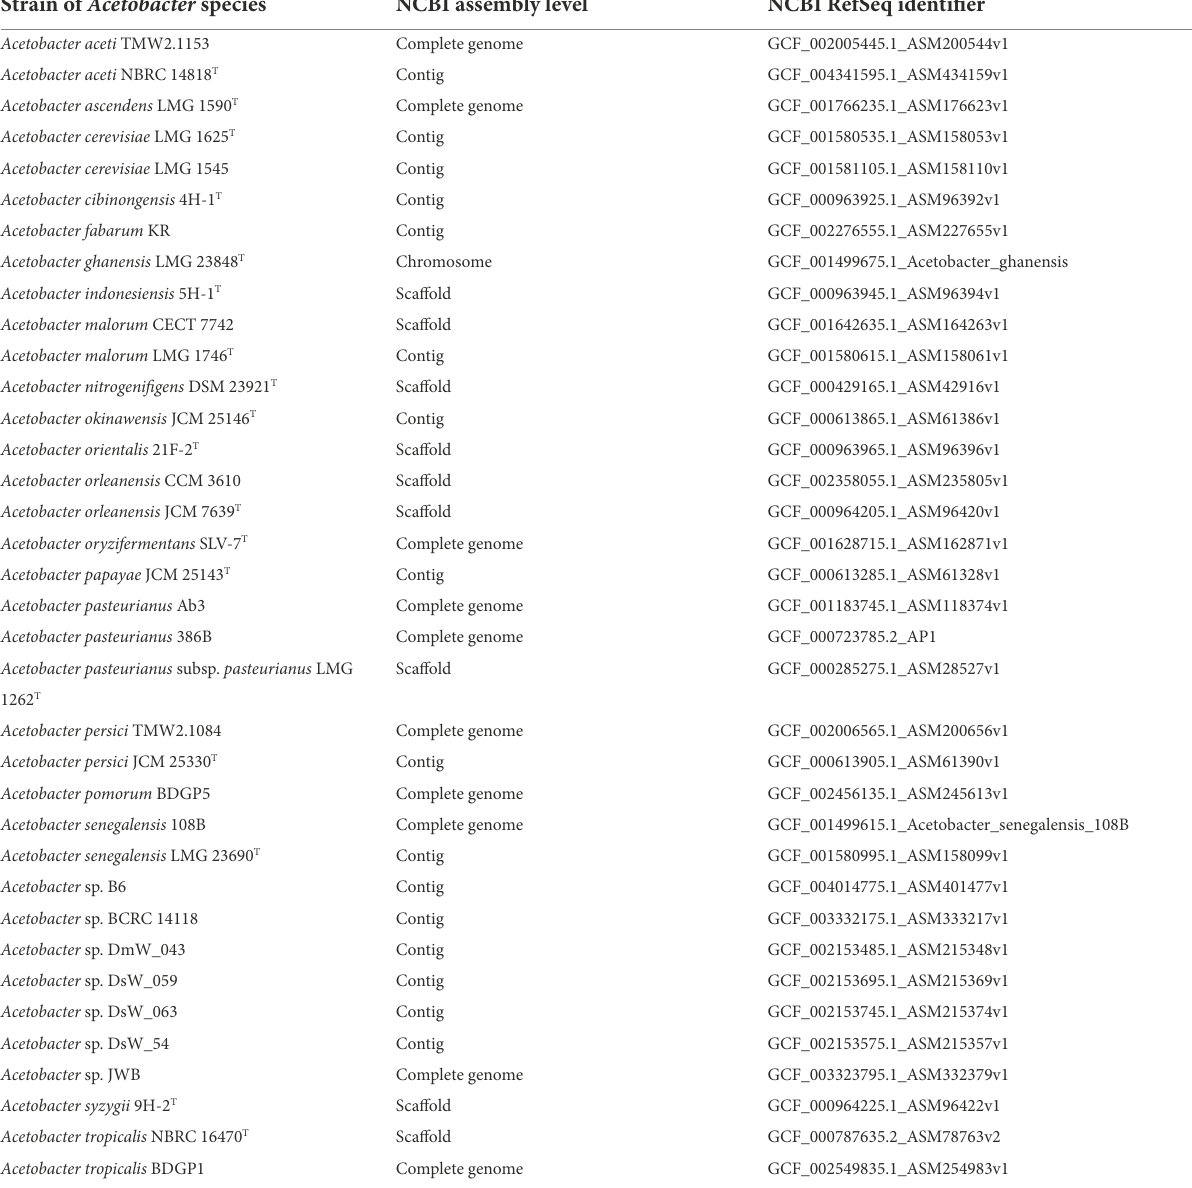
TABLE 2 Selection of Acetobacter genomes used in the OrthoFinder